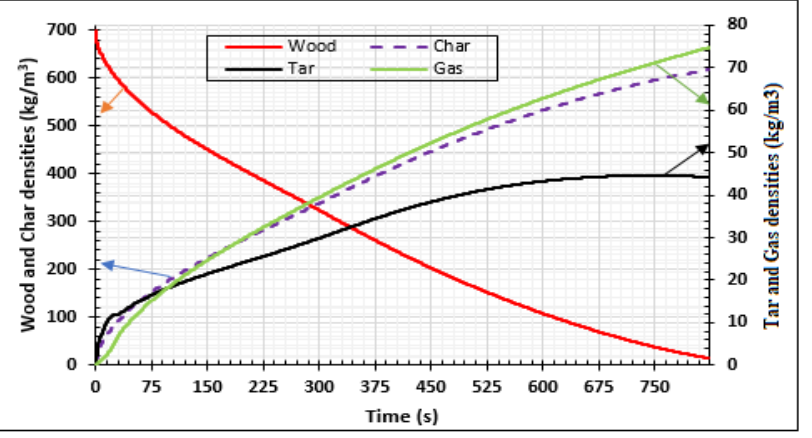
Figure 6. Density variations of wood decomposition, charcoal, tar, and gas productions at Tf = 973.15 K using samples of 30 mm thickness, ρ bo = 700 kg/m 3 .